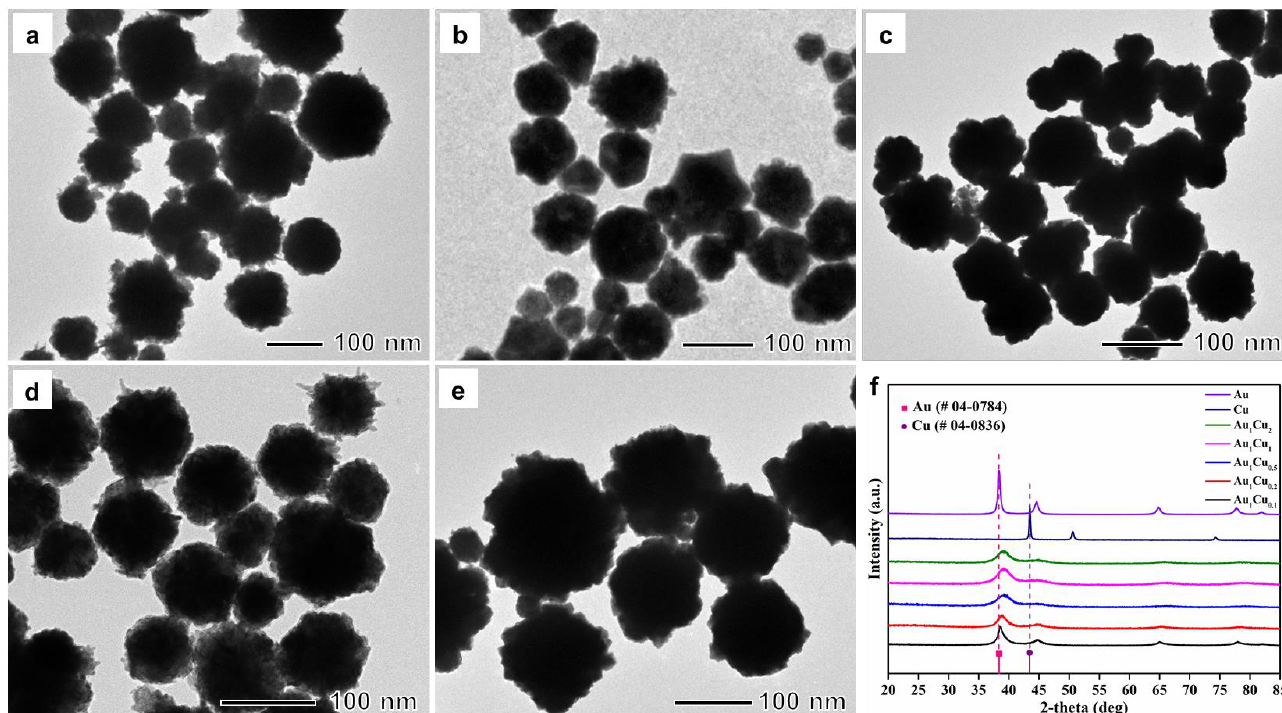
Figure 1. Transmission electron microscopy images of ( a ) Au 1 Cu 0.1 , ( b ) Au 1 Cu 0.2 , ( c ) Au 1 Cu 0.5 , ( d ) Au 1 Cu 1 , and ( e ) Au 1 Cu 2 alloy nanoparticles. ( f ) X-ray diffraction patterns of the Au–Cu alloy Figure 1 : TEM images of (a) Au f, XRD patterns of Au-Cu alloy nanoparticles.